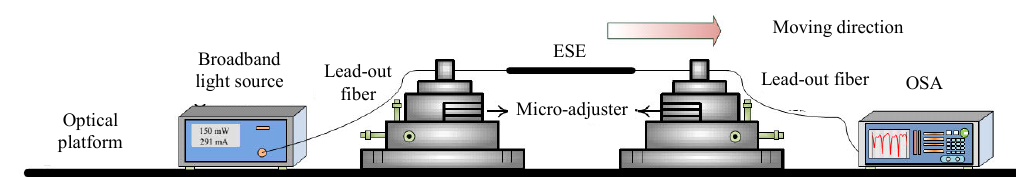
Fig. 7 Configuration of the proposed CSC structure based sensing